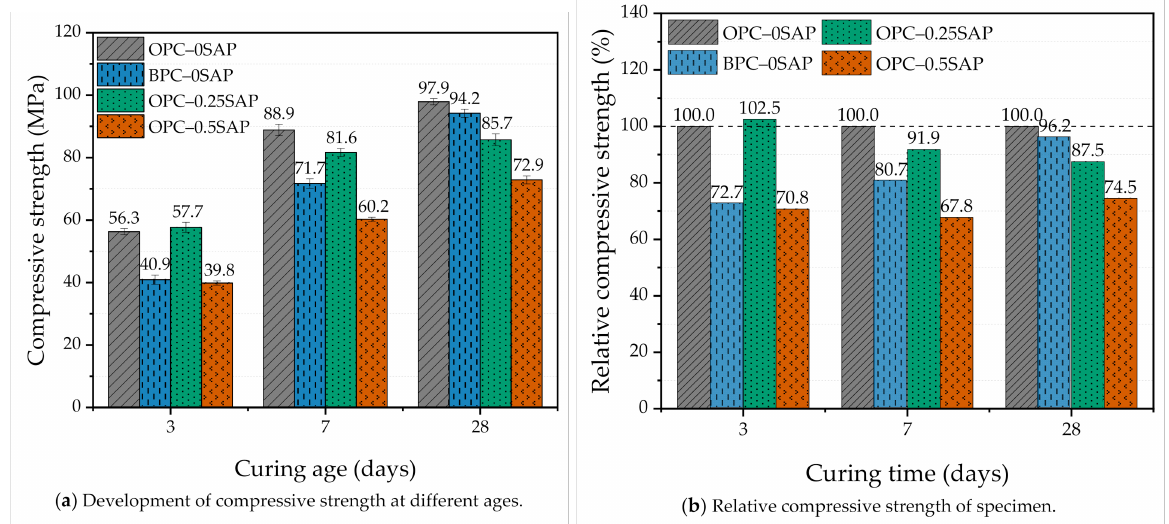
Figure 4. The effect of the amount of SAP added at different ages (3, 7, and 28 days) and the type of cement on the compressive strength. ( a ) Development of compressive strength at different ages; ( b ) relative compressive strength of